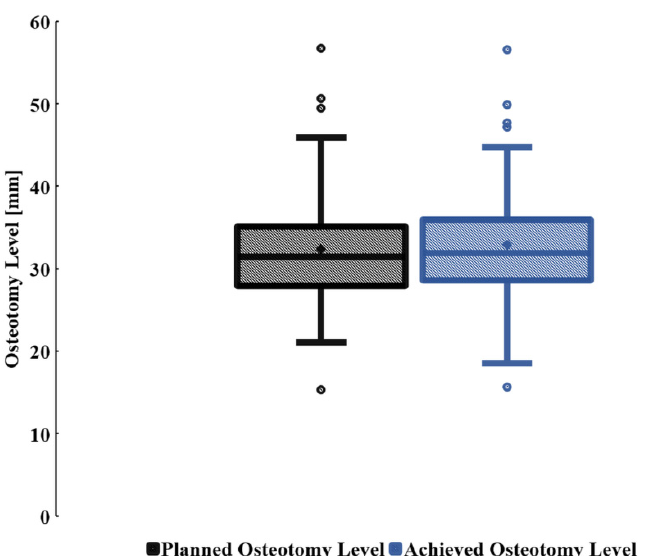
Figure 5. Box plot illustrating the measurements of the planned and achieved osteotomy